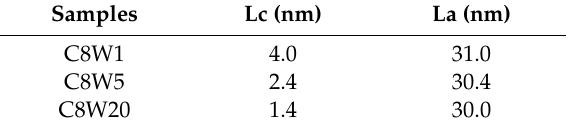
Figure 9. Raman normalization curves of di ff erent samples ( a ) and the amplification view of peak G ( b ). Table 3. Lc and La of AGAs with di ff erent microwave treatment